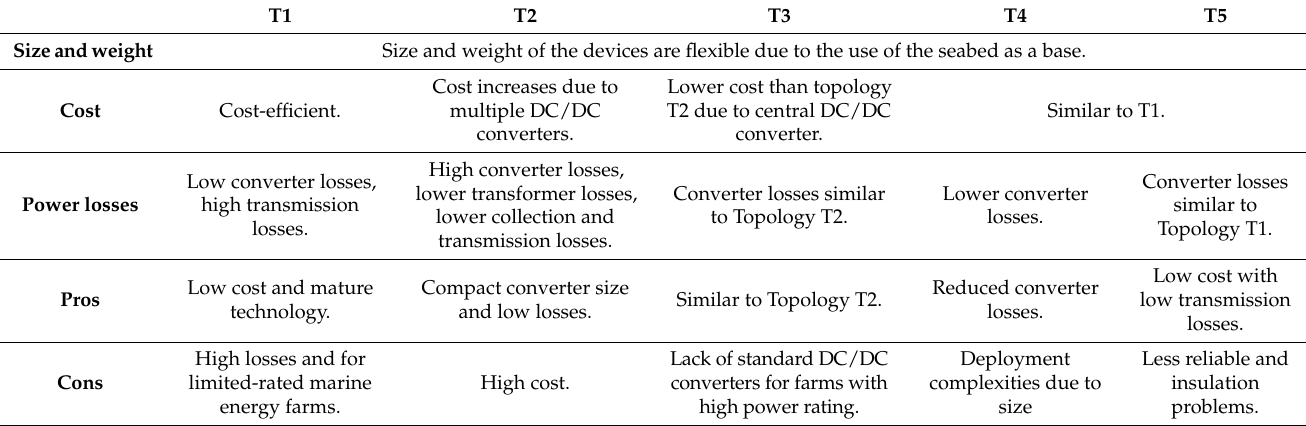
Table 1. Important characteristics for Topologies T1–T5 with a submerged marine energy